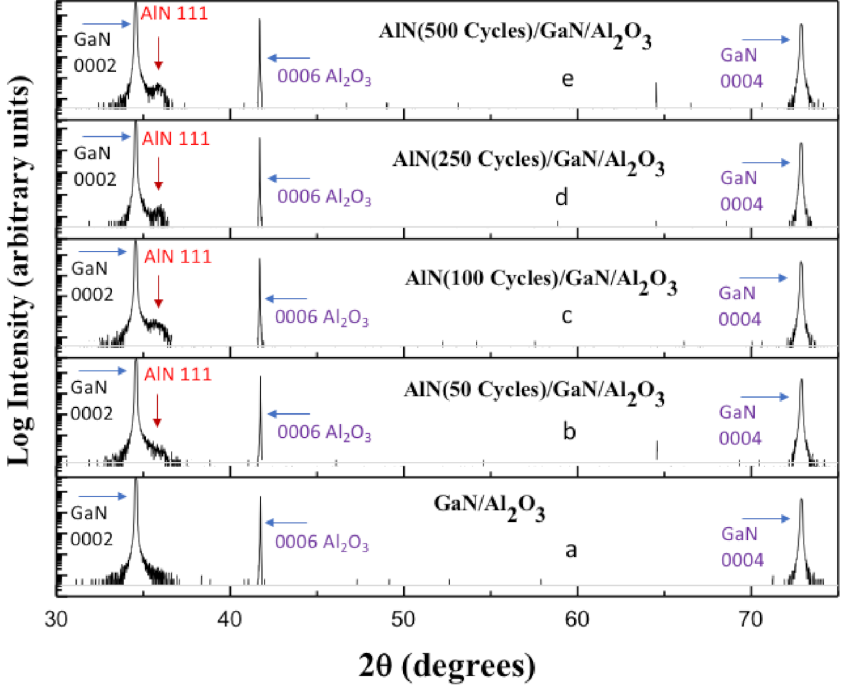
Figure 4. A series of XRD patterns in log scale from AlN films on GaN/sapphire as a function of number of reaction cycles at 420 ◦ C. XRD on GaN/sapphire is shown at the bottom